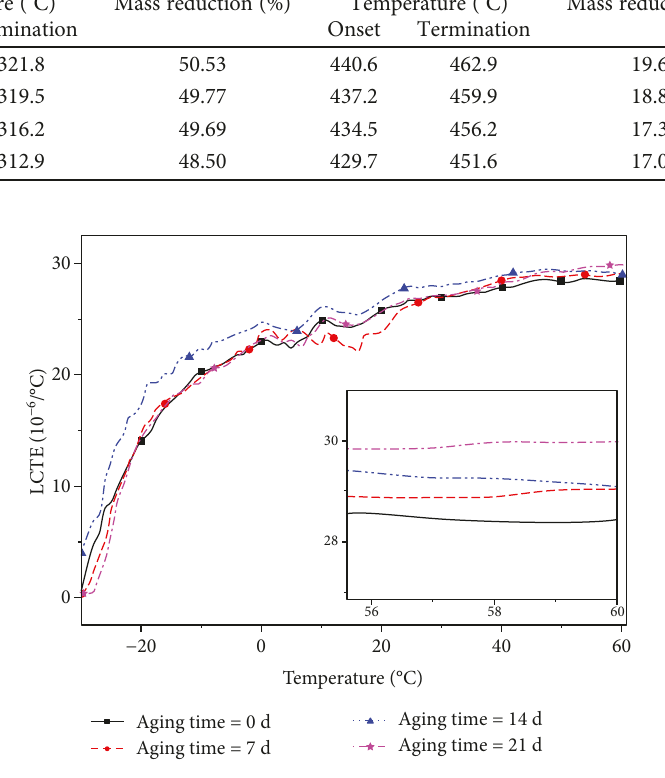
Figure 6: LCTE curve of the